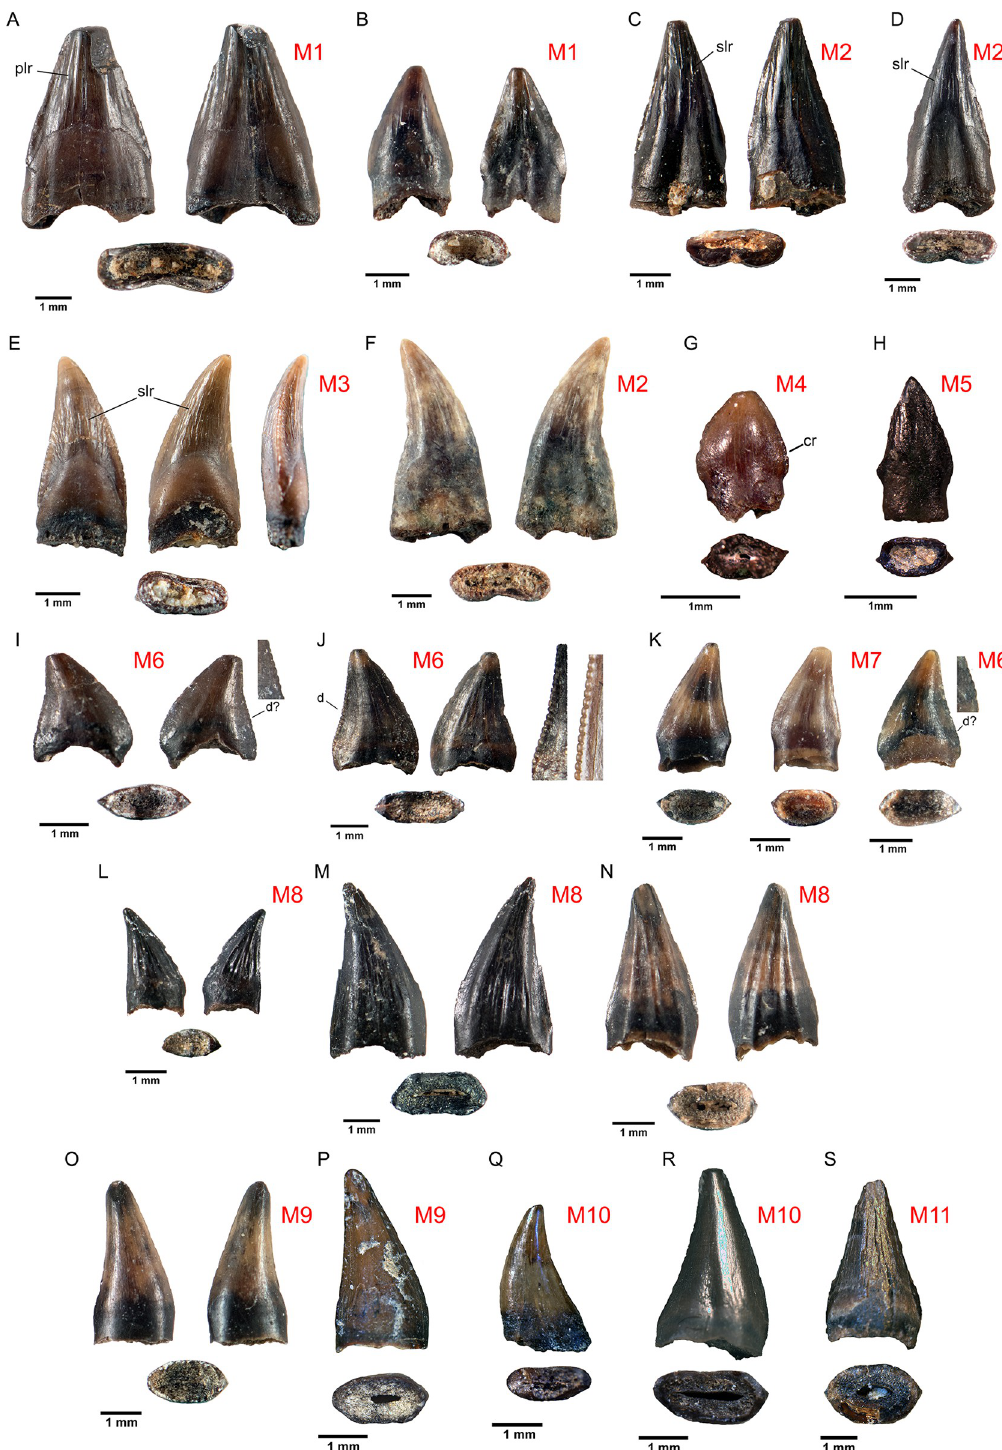
Fig 2. Putative isolated avian tooth morphotypes A, B, Morphotype 1; C, D, F, Morphotype 2; E, Morphotype 3; G, Morphotype 4; H, Morphoytpe 5; I, J, Morphotype 6; K, Morphotype 7; L, M, N, Morphotype 8; O, P, Morphotype 9; Q, R; Morphotype 10; S, Morphotype 11. Abbreviations: cr, crenulations, d, denticles (d? indicates possible denticles), plr, primary longitudinal ridges, slr, secondary longitudinal ridges. For A, B, C, E, F, I, J, K, L, M, N, and O, left is labial, right is lingual. E includes mesial aspect. D, G, and P are in lingual view, and H, Q, R, and S are in labial view. Specimen numbers are listed in S1 File. https://doi.org/10.1371/journal.pone.0283581.g002 PLOS ONE | https://doi.org/10.1371/journal.pone.0283581 March 28,